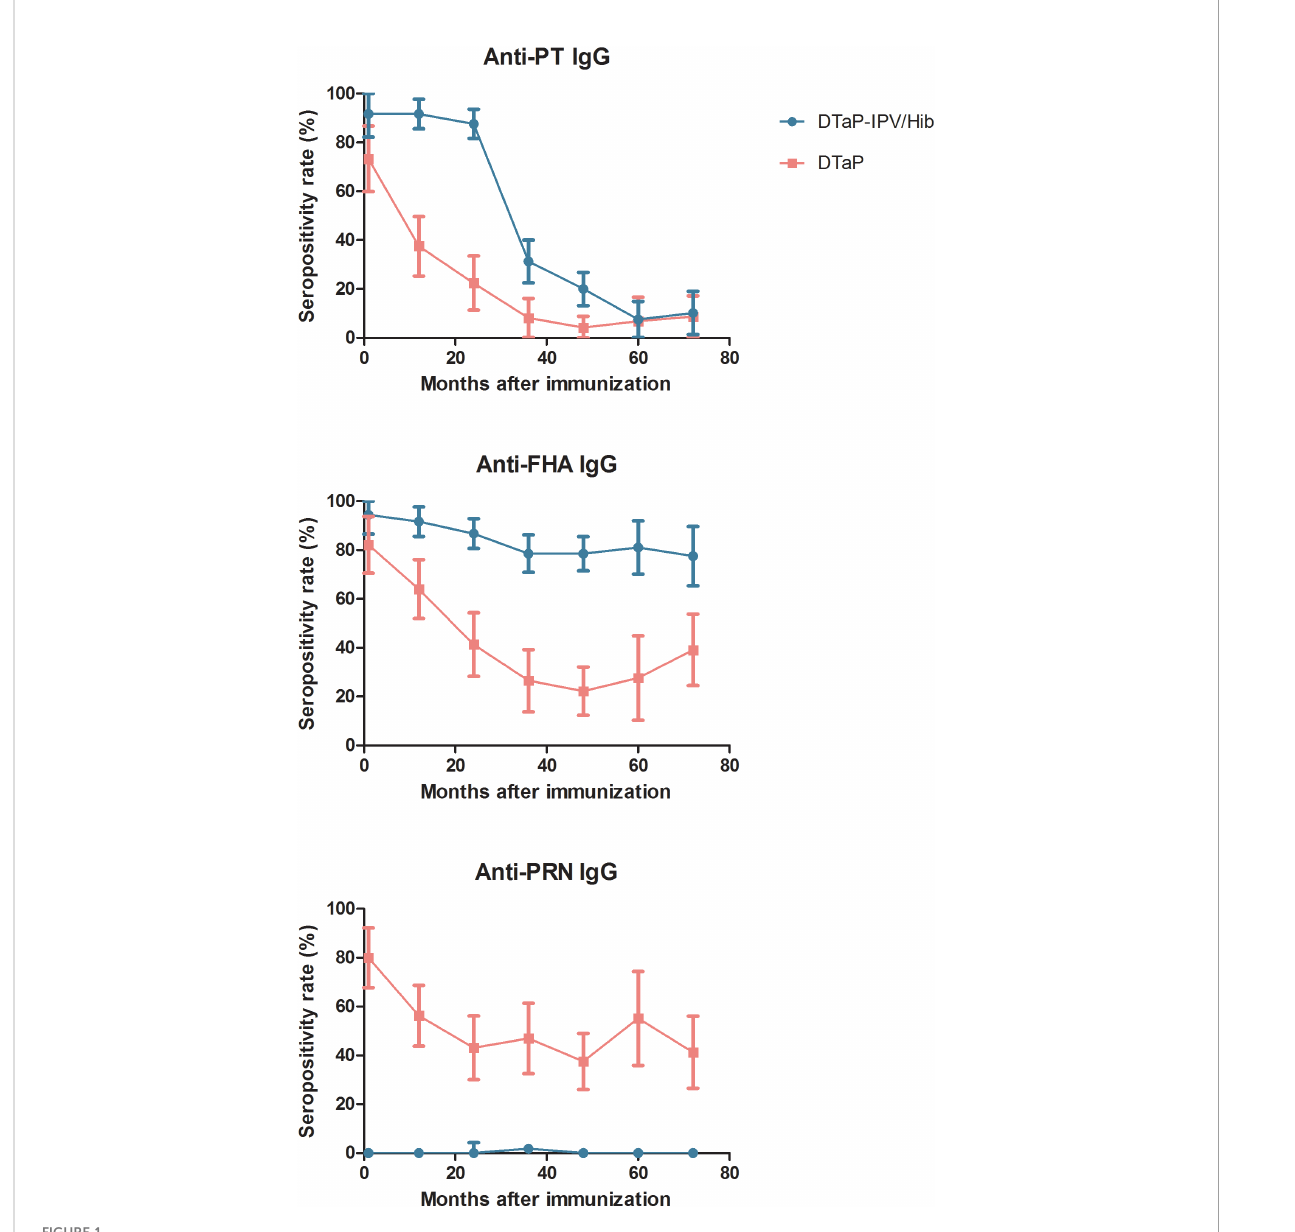
FIGURE 1 Seropositivity rate of pertussis IgG between the two